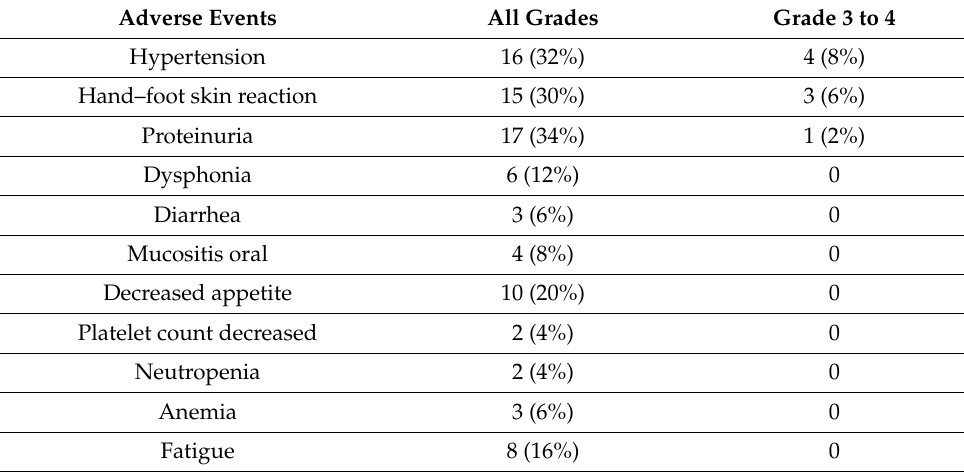
Figure 1. Antitumor activity of low − dose apatinib monotherapy as the third − line treatment in patients with metastatic colorectal cancer. ( A ) Best percentage changed from the baseline in measurable tumor lesions shown by a waterfall plot. ( B ) Kaplan − Meier survival curve of the PFS of the patients from low − dose apatinib treatment. ( C ) Kaplan − Meier survival curve of OS of the patients from the low − dose apatinib treatment. ( D ) PFS and ( E ) OS in patients who were previously treated with or without bevacizumab. mCRC = metastatic colorectal cancer, OS = overall survival, and PFS = progression − free survival. Table 2. Low-dose apatinib treatment-related adverse